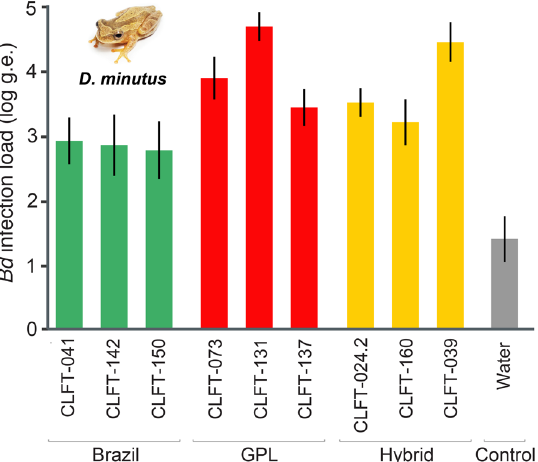
Figure 3. Average infection burdens 60 days post-inoculation ( ± SE) for Dendropsophus minutus inoculated with Bd -Brazil (green bars), Bd -GPL (red bars), and hybrid genotypes (yellow bars); each bar represents a different Bd genotype. Gray bar depicts natural infection burdens of the control group after 60 days